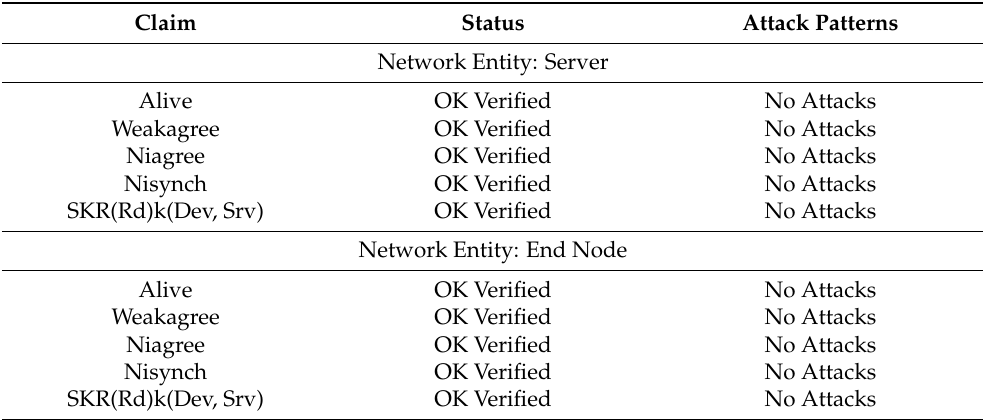
Table 1. Security Analysis Results of the LPWAN Session Key